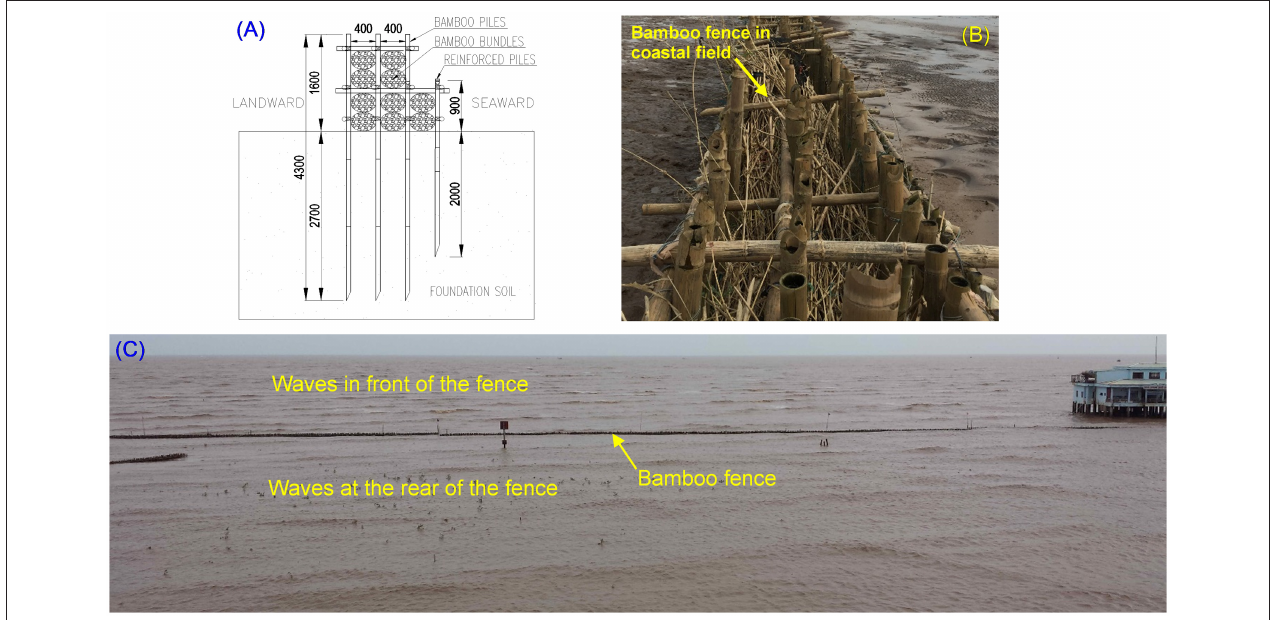
FIGURE 2 | Cross-section of bamboo fences (A) , bamboo fences at the coastal site (B) , and incident and transmitted waves at the coastal site (C) .